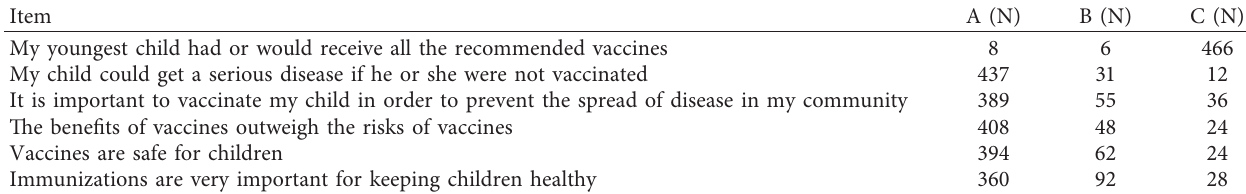
Table 2: Attitudes and behaviors regarding vaccination importance and safety of parents surveyed. Item